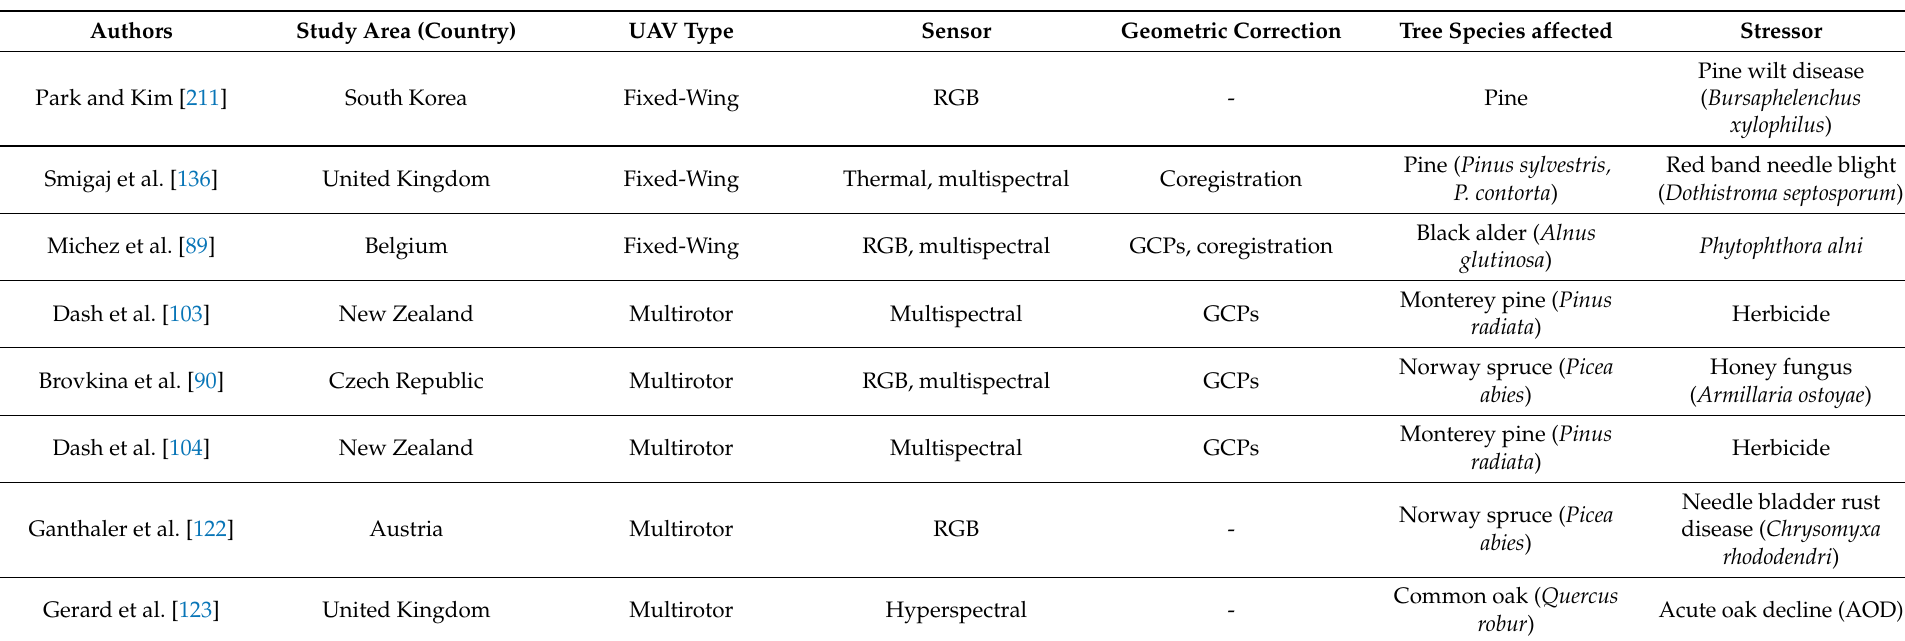
Table A2. Diseases: reviewed articles on diseases as the cause of tree